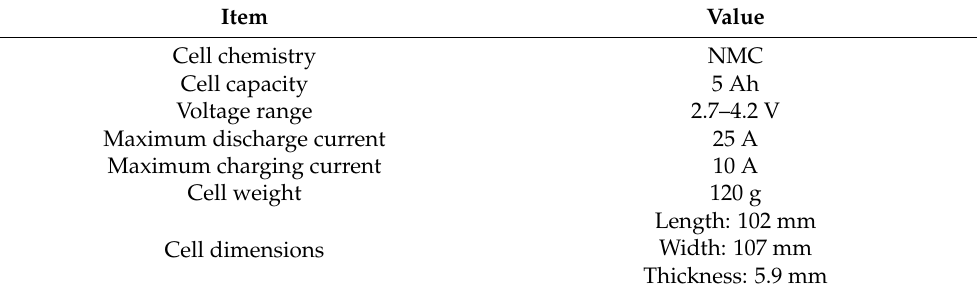
Table 4. Pouch cell